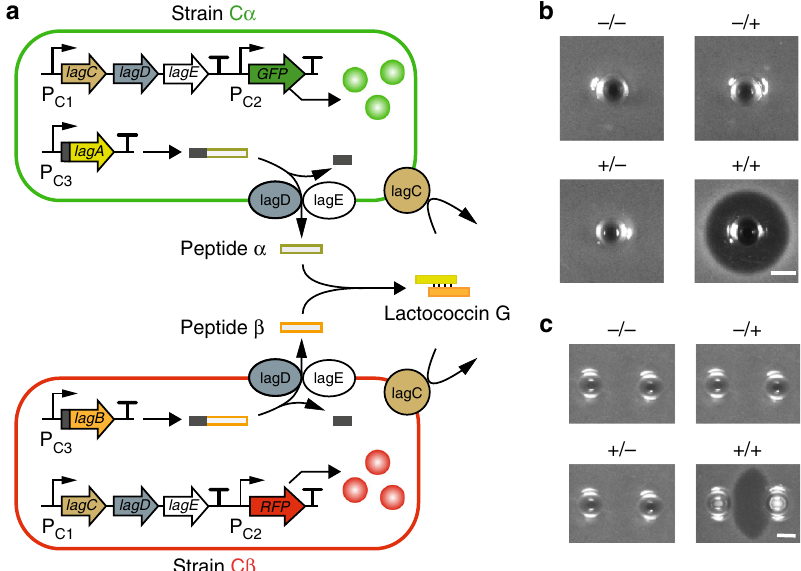
Fig. 1 An engineered cooperation between two bacterial strains. a Circuit design. The cooperative consortium consists of two L. lactis strains, C α and C β . C α carries three constitutively expressed genes lagA , lagD and lagE , allowing to synthesize and secret the α subunit of the bacteriocin lactococcin G (lcnG). C β harbors three constitutively expressed genes lagB , lagD and lagE , which enables the synthesis and secretion of the β subunit of lcnG. The two subunits, α and β , autonomously assemble into lcnG that inhibits L. lactis strains. Meanwhile, C α and C β both carry lagC , the lcnG immunity gene, and respectively have the fl uorescence reporter genes yemGFP and mCherry . b Single-well inhibition zone assays. The four wells were loaded with blank culture (GM17 media supplemented with chloramphenicol) ( − / − ), blank culture and C β supernatant ( − / + ), C α supernatant and blank culture ( + / − ), and C α and C β supernatants ( + / + ) accordingly. L. lactis NZ9000 loaded with a chloramphenicol resistant gene was used as an indicator strain. An inhibition zone was observed around the ( + / + ) well containing the both supernatants. c Double-well inhibition zone assays. The left and right wells were loaded with blank culture and blank culture ( − / − ), blank culture and C β supernatant ( − / + ), C α supernatant and blank culture ( + / − ), and C α and C β supernatants ( + / + ) accordingly. L. lactis NZ9000 loaded with a chloramphenicol resistant gene was used as an indicator strain. An inhibition area was observed between the wells loaded with the C α and C β supernatants respectively. In panels b and c , scale bars, 3